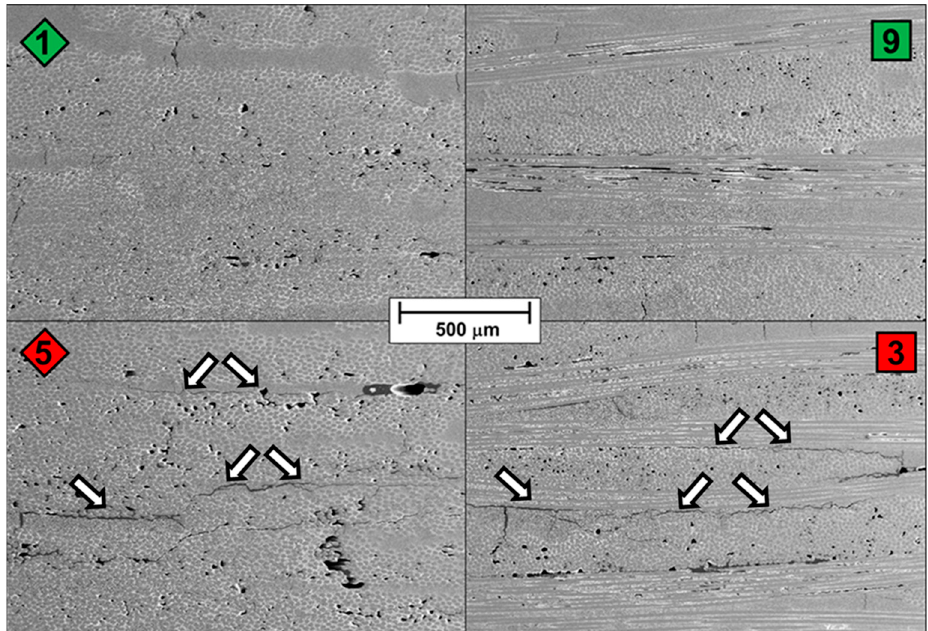
Figure 10. SEM-cross sections of characteristic samples show the quasi crack-free microstructures of ‘stronger’ samples #1 (±45° cut) and #9 (0/90° cut) (upper row) compared to ‘weaker’ samples #5 and #3 which display small microcracks mostly aligned parallel to fiber fabric laminates.